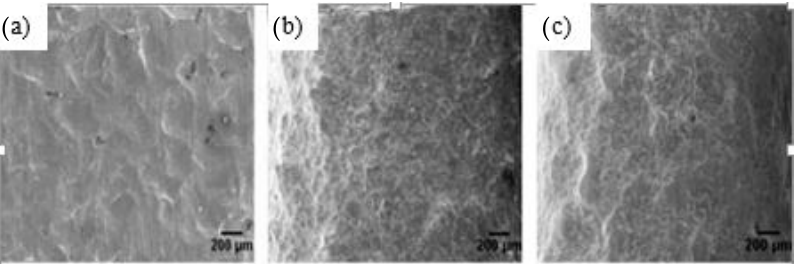
Figure 4. SEM of cast iron surfaces developed by ( a ) SP; ( b ) SSP and ( c ) RSSP. Reproduced with permission from [71]. Copyright Elsevier, 2014.